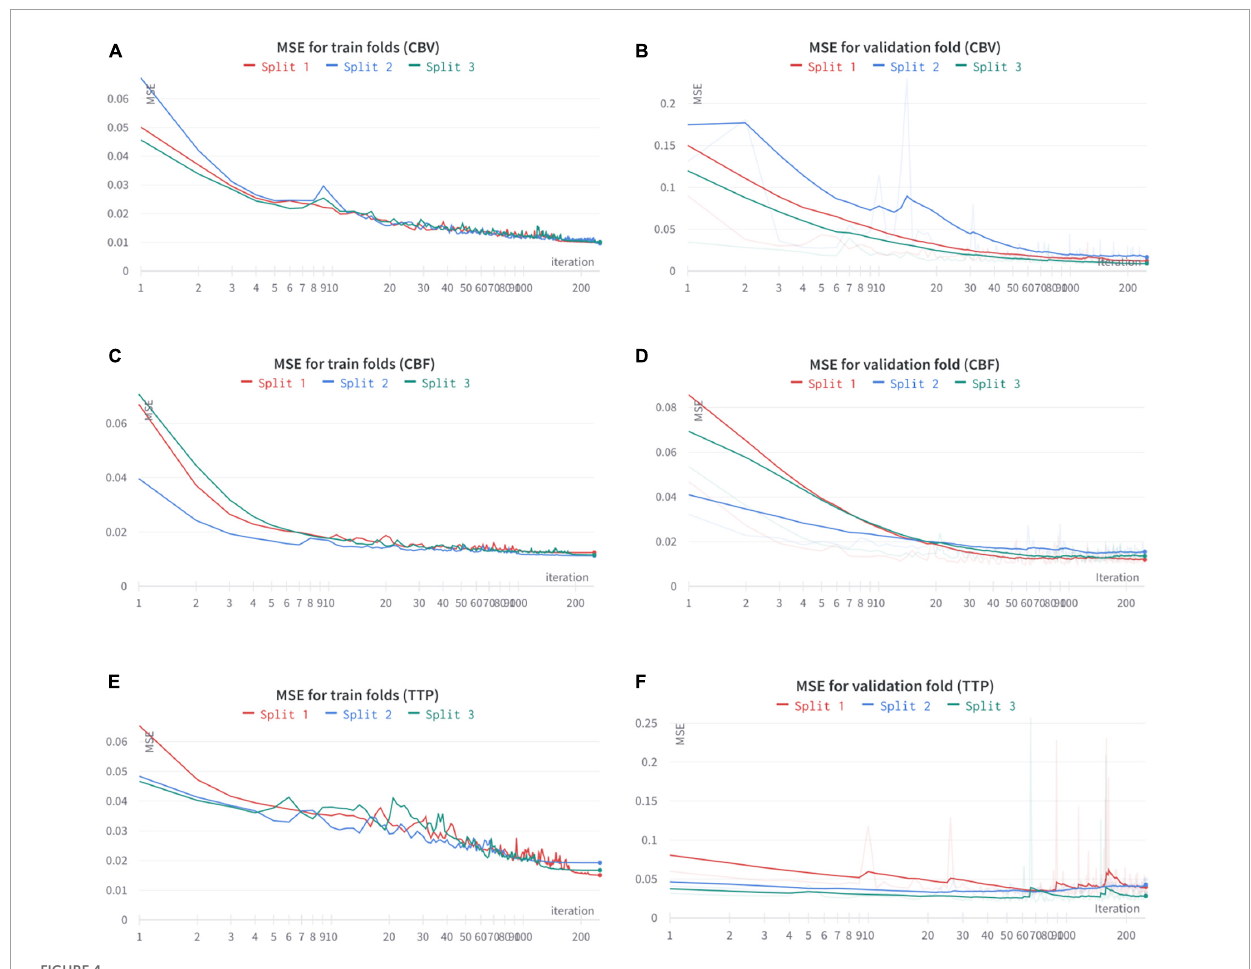
FIGURE4 Train and validation curves for the threefold cross-validation results on CBV (A,B) , CBF (C,D) , and TTP (E,F) .